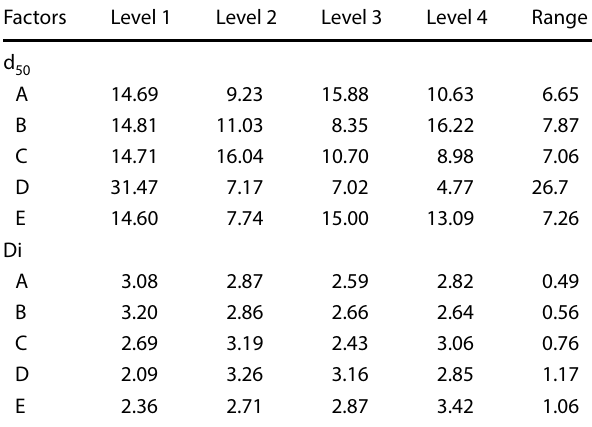
Fig. 2 Cumulative percentage vs particle size for each sample pow- der